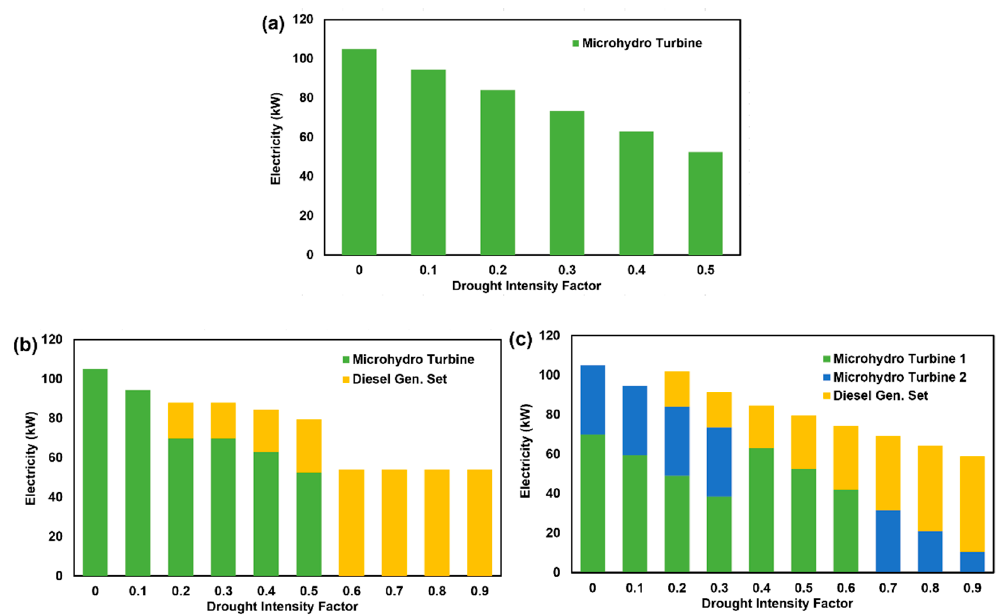
Figure 12. The resulting electricity generation contribution for ( a ) case study 1, ( b ) case study 2, ( c ) case study 3.